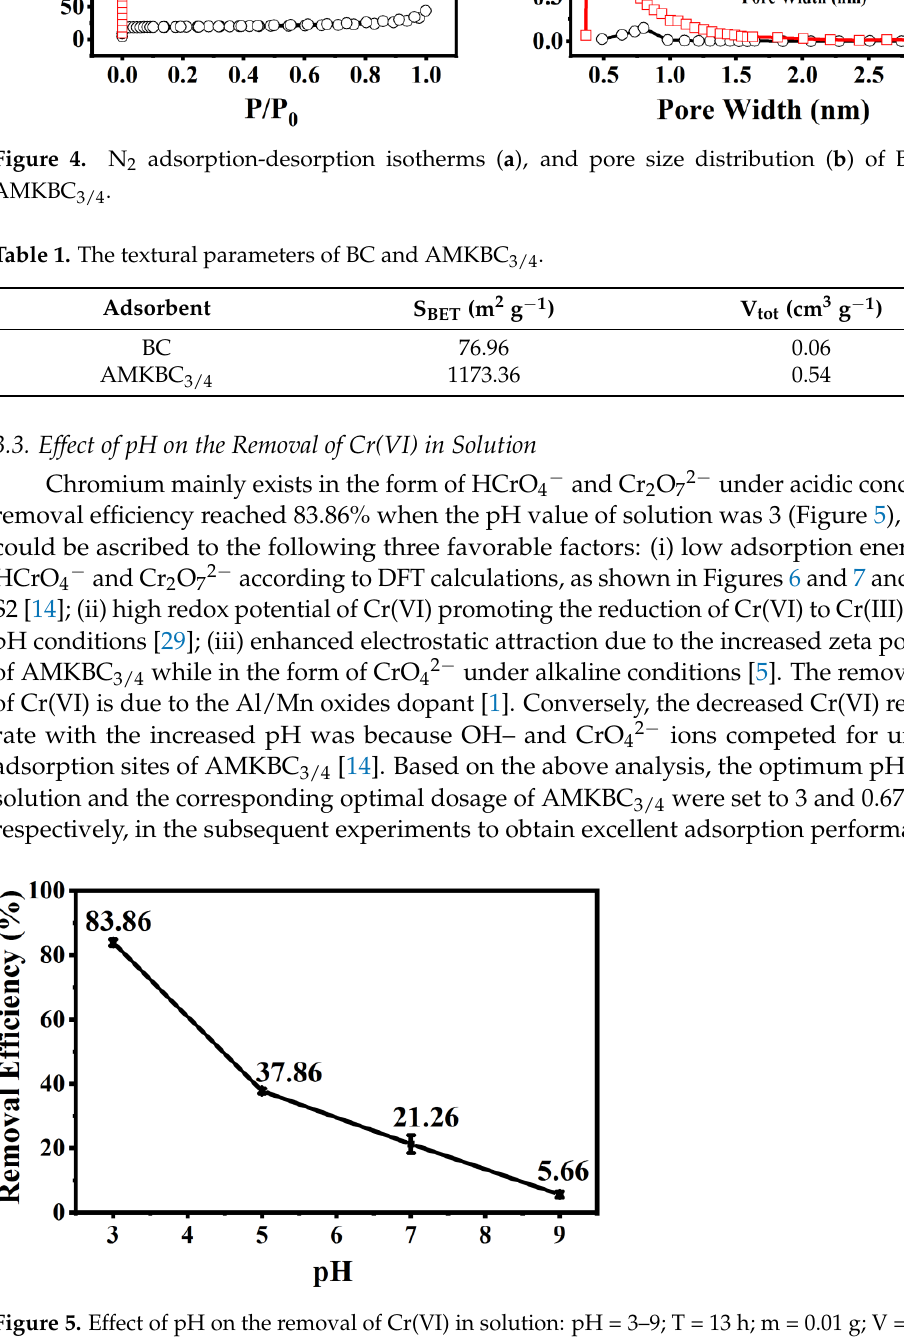
Figure 6. Optimized geometric configurations for HCrO 4 − adsorbed on MnO(001) ( a , b ), and isosurface representations of charge difference ( c , d ). The accumulation and depletion of electrons are represented by the yellow and cyan regions, respectively. Isosurface value = 0.002 e/bohr 3 . Manganese atoms are purple, oxygen atoms are red, chromium atoms are blue, and hydrogen atoms are white.